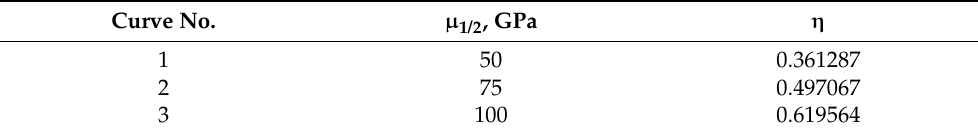
Table 1. Parameters of the shear modulus variation with the coating depth. Curve No.